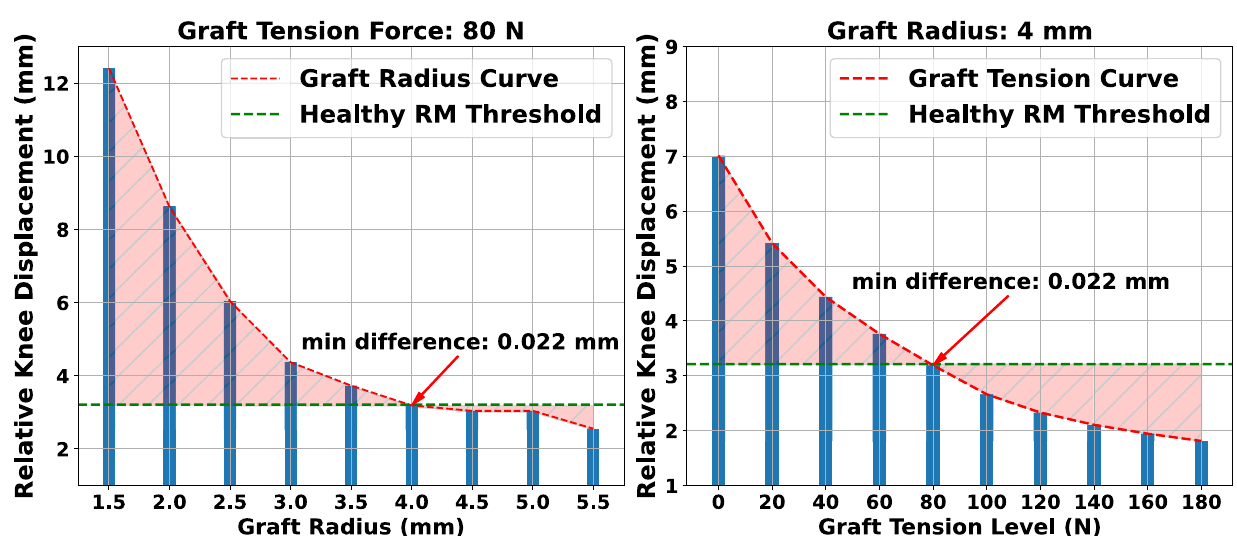
Figure 7. Effect of graft radius and pretension on knee laxity for a semitendinosus graft. The “difference” term refers to the absolute difference in relative knee displacement between each ACLR FE model and the RM. Increasing the graft radius for a specific pretension load reduces relative displacement. The same applies when increasing graft pretension for a fixed value of graft